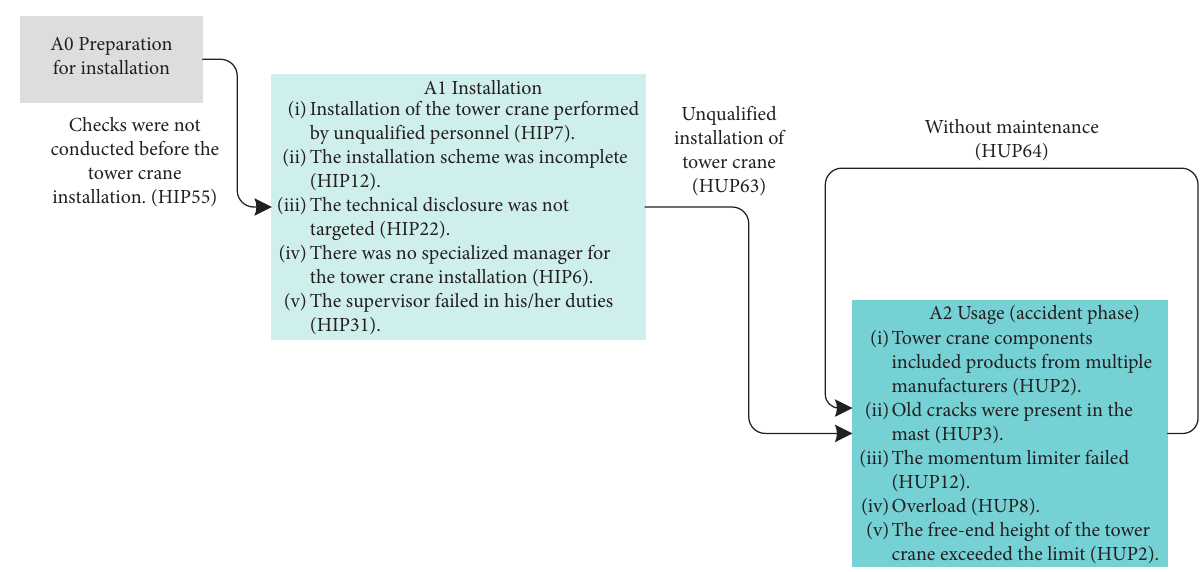
Figure 11: Hazards associate with the